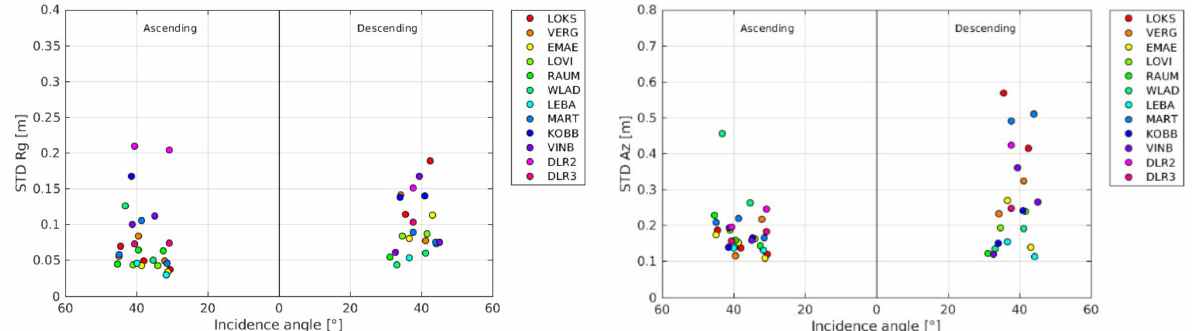
Figure 3. Empirical estimation of ECR SAR observation quality for the different pass geometries observed with the ECR network (colors indicate individual stations) after applying all data corrections. Standard deviation of residuals derived from surveyed ECR positions and measured SAR data filtered for outliers. Standard deviation of range measurements per geometry ( left ) and standard deviations of azimuth measurements per geometry ( right